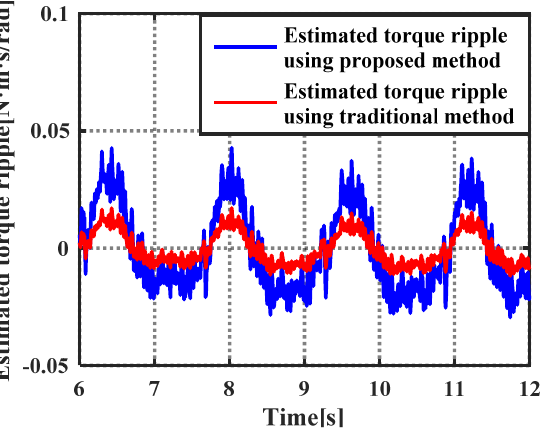
Figure 16. Estimated results of Torque ripple using (18) and the proposed method.